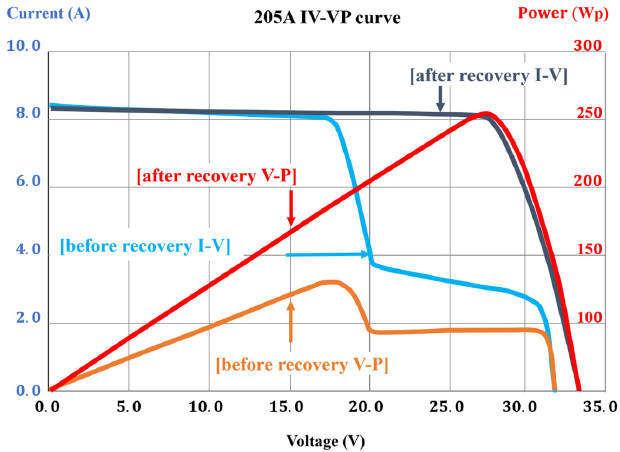
Figure 10. I–V and V–P curves in the module before and after recovery (205A).